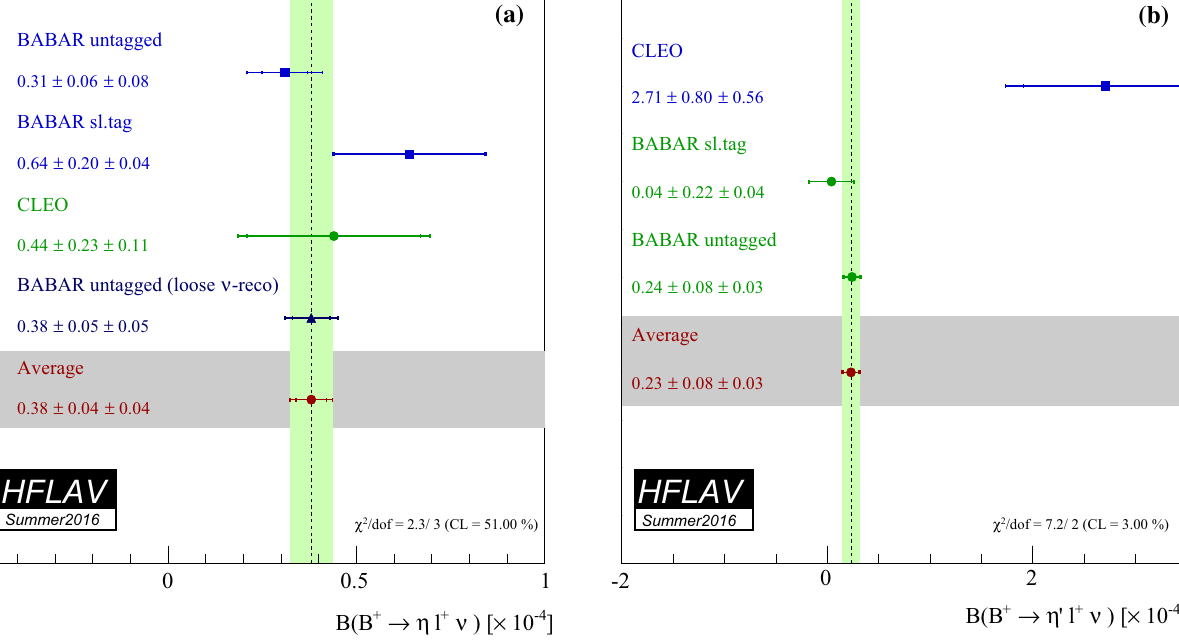
enter via the signal models used for the determination of